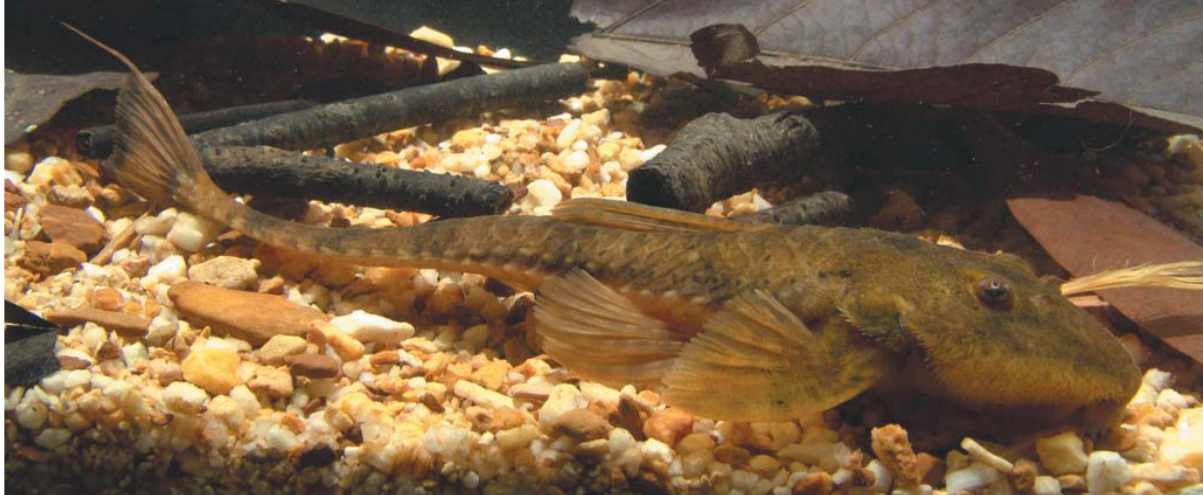
Fig. 2. Rineloricaria osvaldoi , holotype, MZUSP 89022, male, alive, prior to fixation.